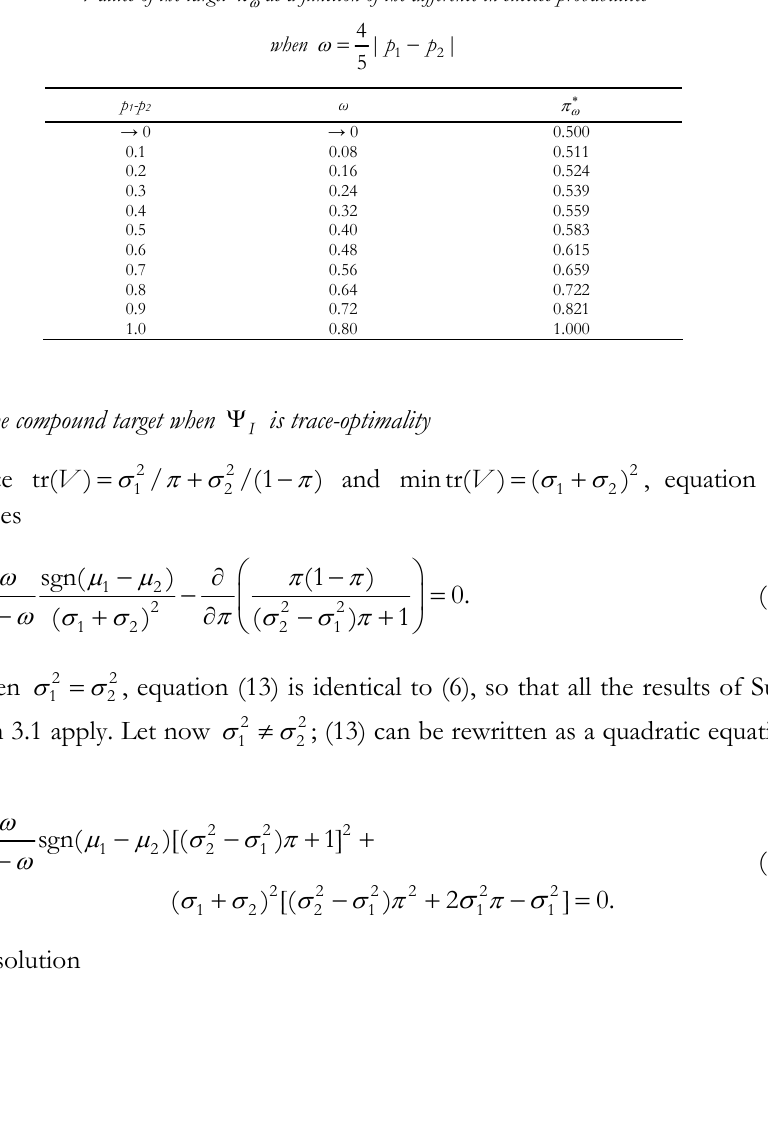
Values of the target